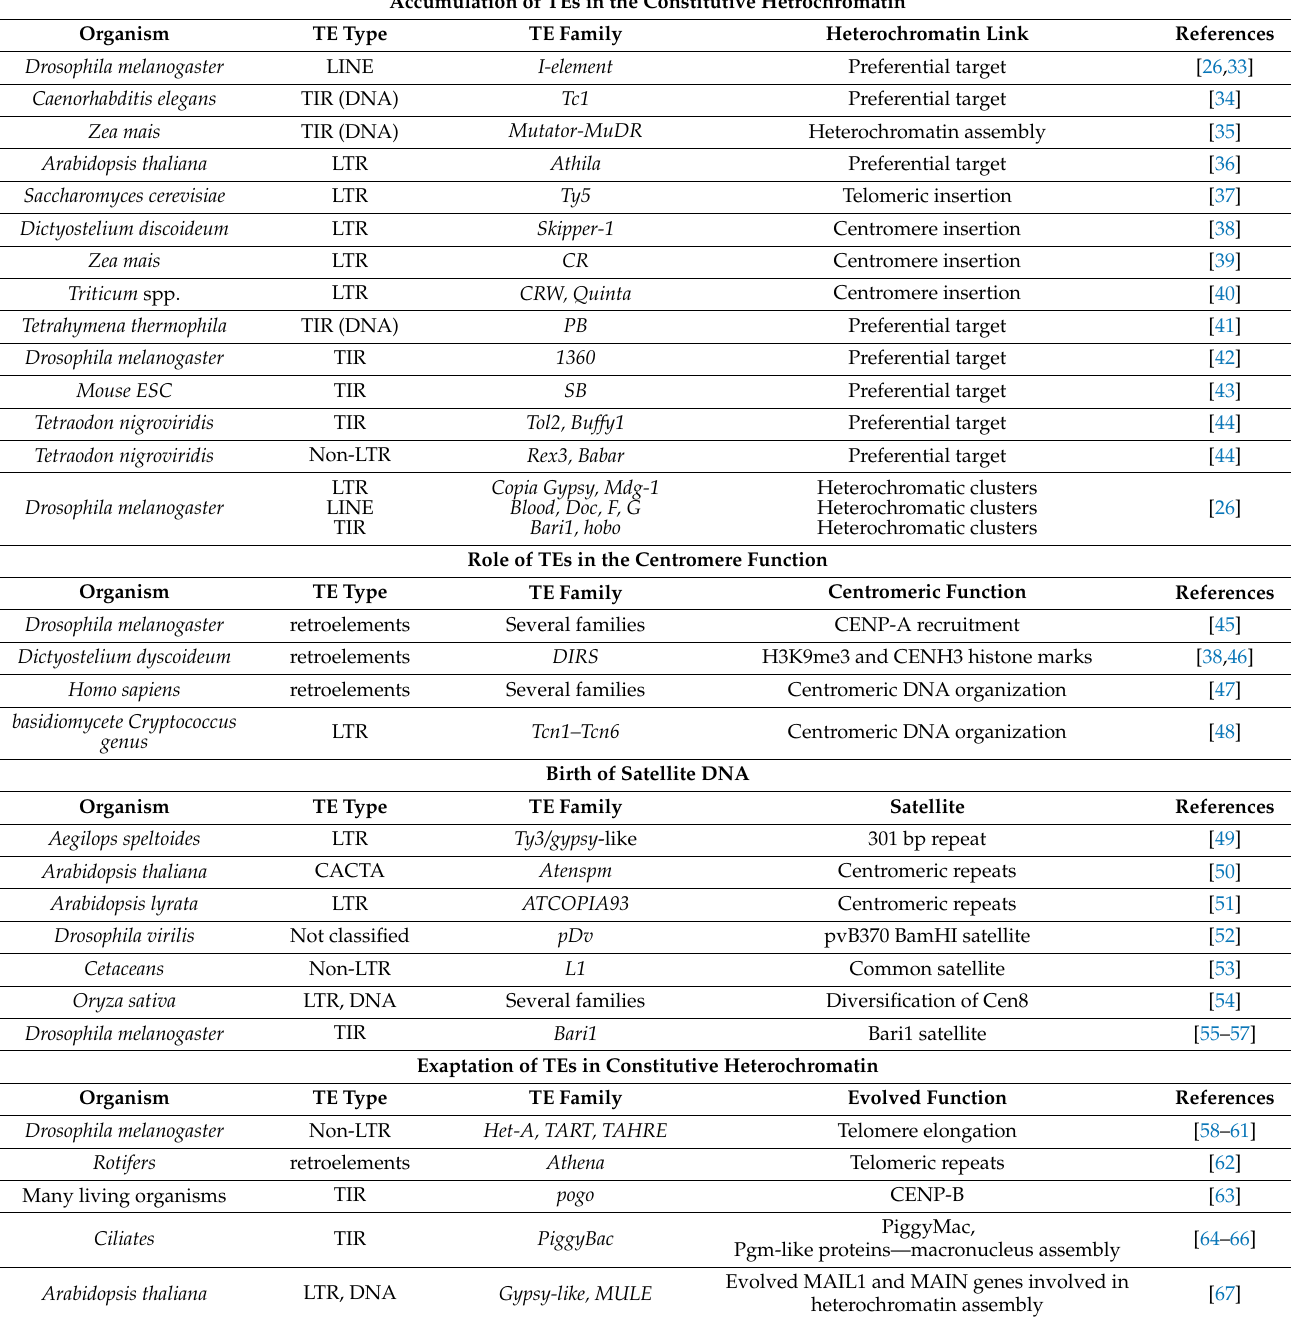
Table 1. The accumulation of TEs in constitutive heterochromatin and their involvement in genome